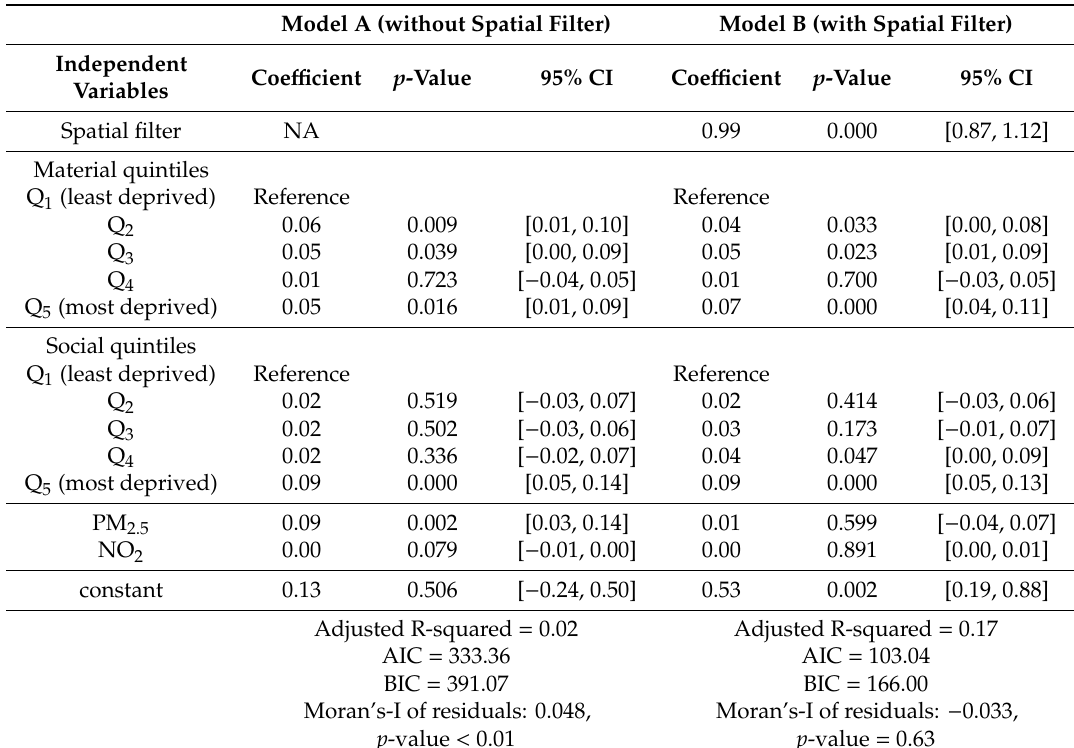
Table 2. Multivariable linear regression models (without and with spatial filter) on the association between smoothed-SPR and independent variables for Calgary.